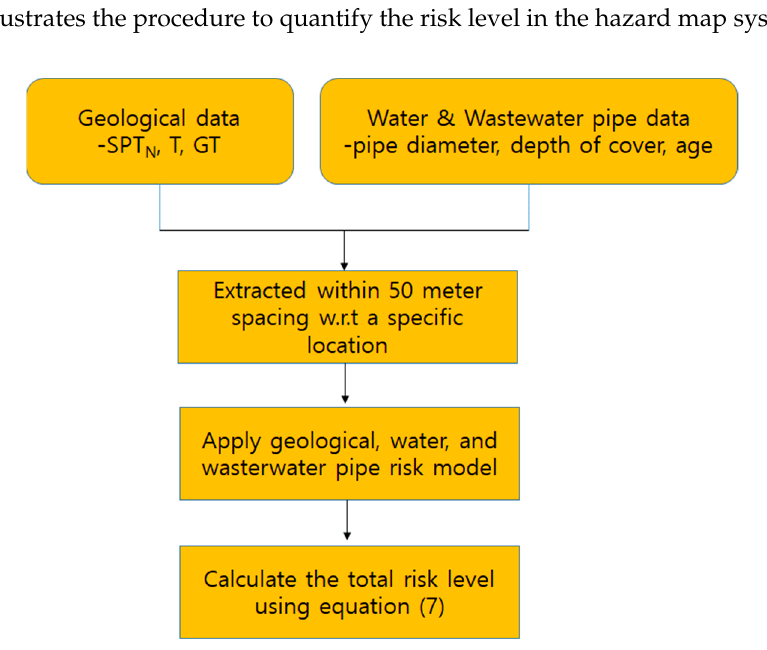
Figure 7. Procedure to determine the risk index in the hazard map system.